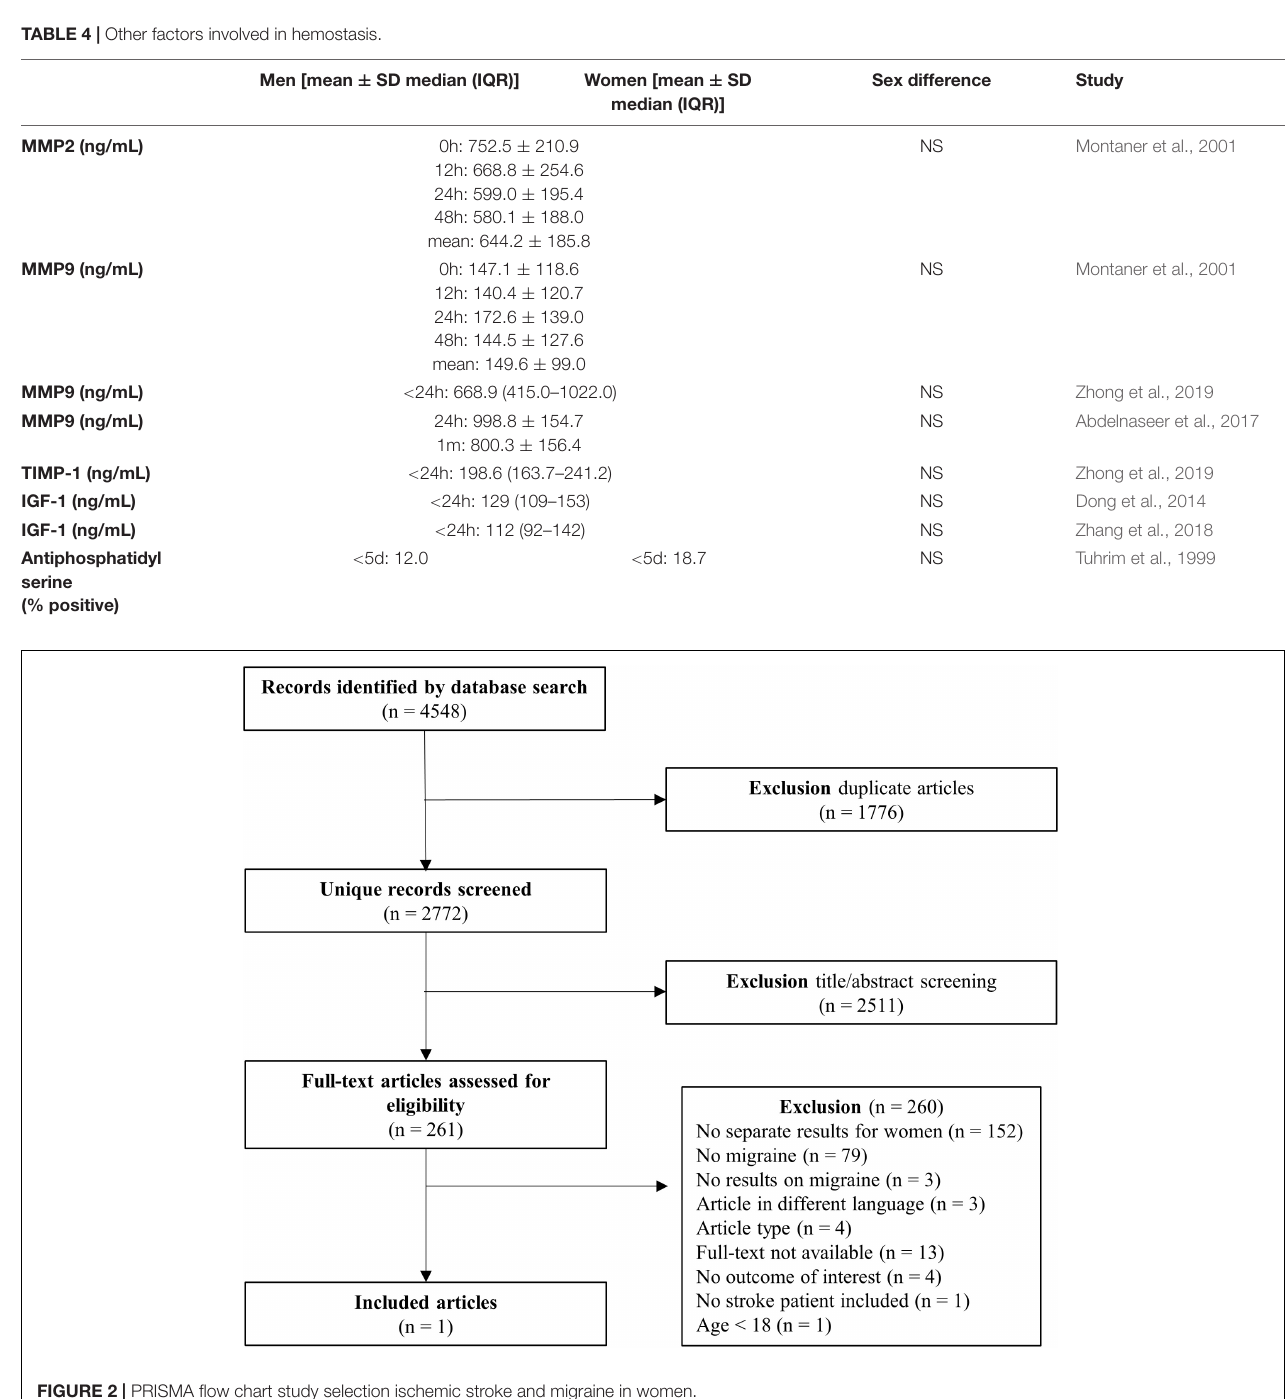
P-selectin is released by activated platelets and endothelial cells (Blum et al., 2012). Fibrinogen is an acute phase reactant. We found no sex differences in levels of fibrinogen between men and women, but in women fibrinogen levels differed between cortical and lacunar location which could point to differences in underlying disease mechanisms. Interestingly, high levels of some